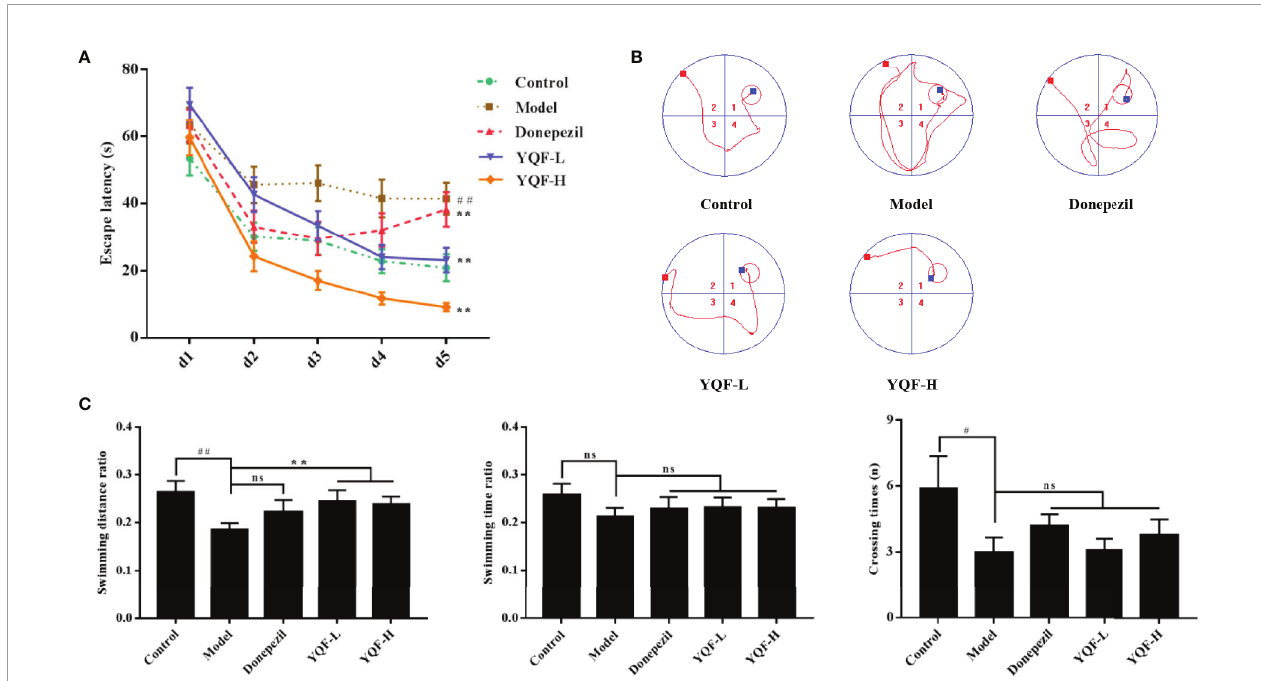
FIGURE 1 | YQF extract ameliorated cognitive de fi cits of aged rat in the MWM test. (A) Mean EL during the training phase from day 1 to day 5. (B) Representative swimming paths of aged rat on 5th day of MWM test. (C) Percentage of time spent, swimming distance in the target quadrant, and number of crossings of the platform on the 6th day. The data are expressed as mean ± SEM, n = 10. # p < 0.05, ## p < 0.01, compared with control group; ** p < 0.01, compared with model group. ns, no signi fi cant